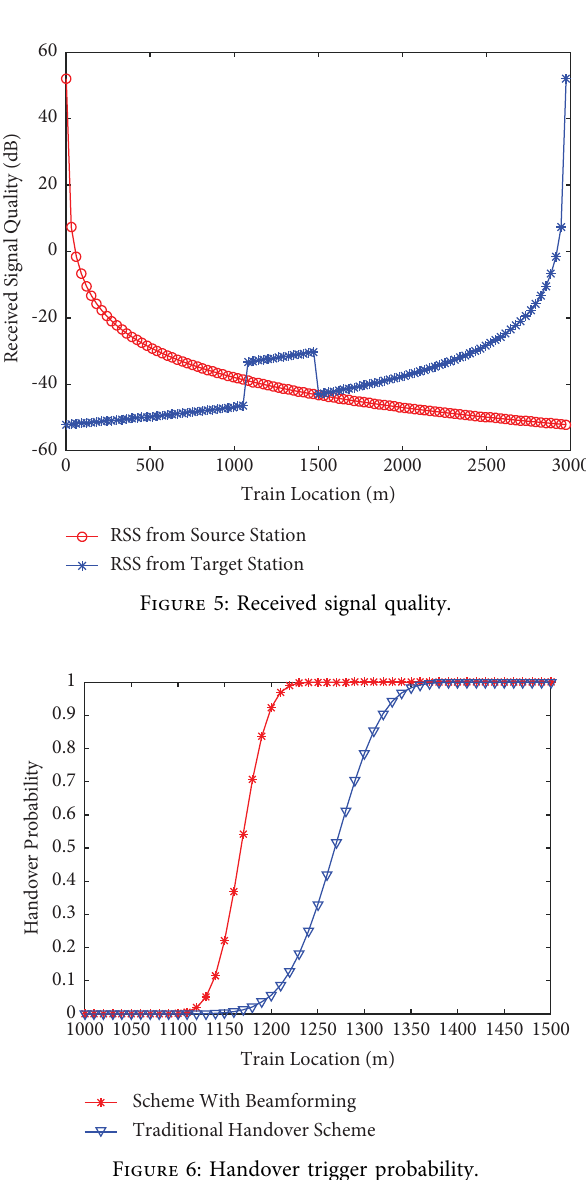
Figure 6: Handover trigger probability.